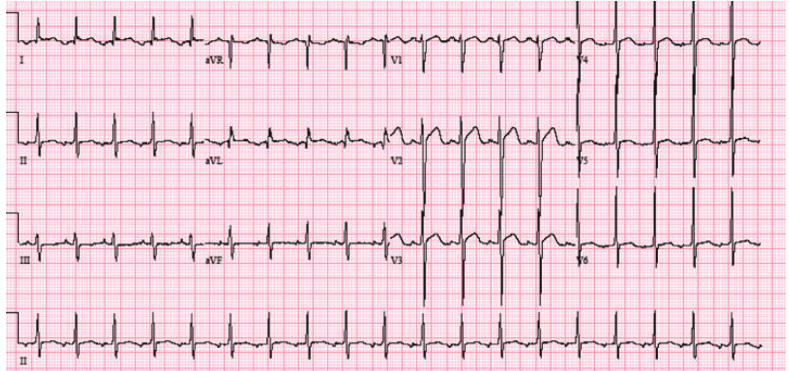
Figure 2: 12 lead ECG. P wave become obvious as the heart rate decrease from 139 to 115. P waves are inverted in lead II and AVL, while the P waves were upright in III and AVF, suggesting the possibility of ectopic atrial tachycardia, most likely originating from the left side.